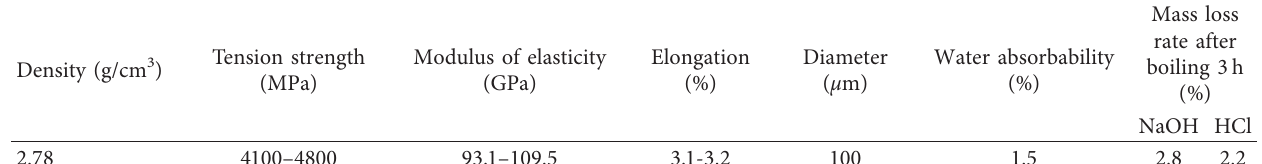
Table 4: Technical parameters of the basalt fiber.